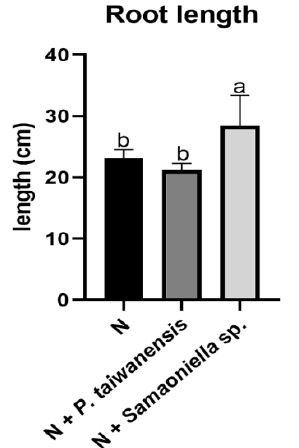
Figure 5. Root length promotion effect in greenhouse trial 1. N is the nematode-only treatment. Different letters indicate significant differences among treatments by Fisher’s LSD test ( P < 0.05), respectively.